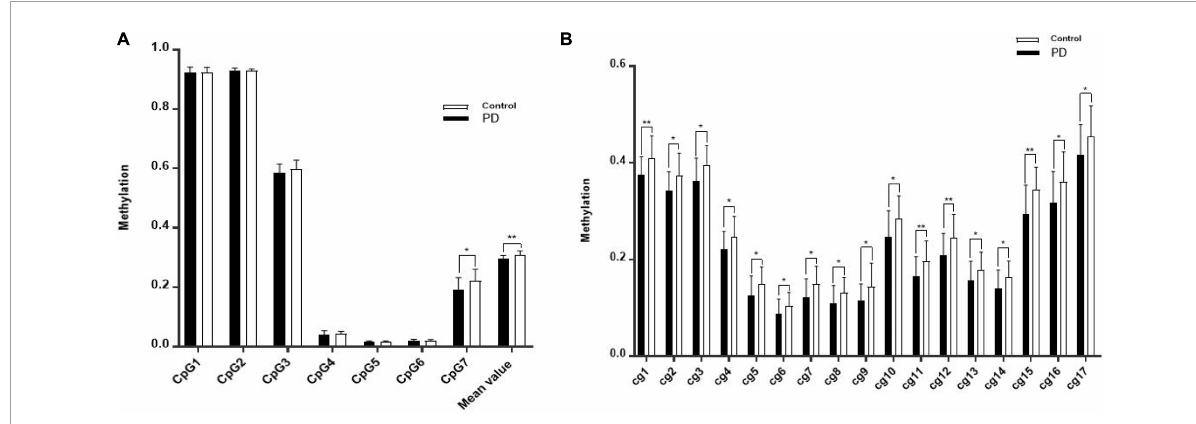
FIGURE2 (A) The methylation of CpG islands in hTERT gene in the discovery sample of patients with PD and HCs. (B) The lower methylation in PD compared with controls. “*” Significant at P < 0.05; “**” significant at P <